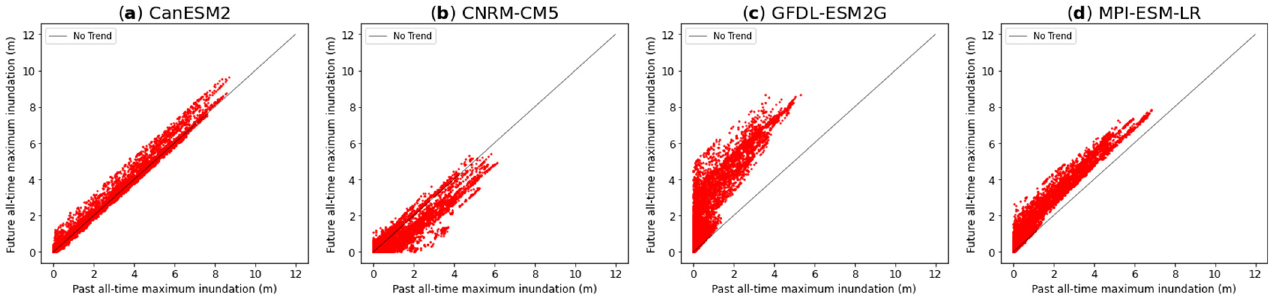
Figure 13. Past vs. future all-time seasonal maximum inundation during the NE monsoon of the selected GCMs ( a – d ).